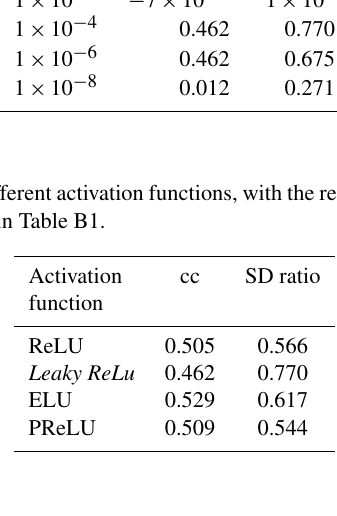
Table B4. Different hidden-layer amounts, with the rest of the pa- rameters fixed as in Table